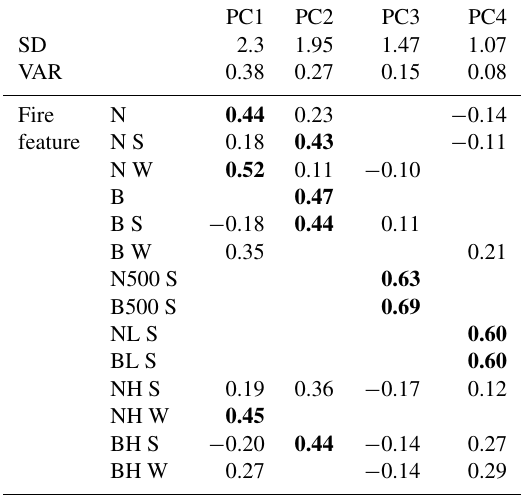
Table 4. Varimax rotation correlation values, standard deviation (SD) and variance (VAR) from principal component analysis on Sen’s slope results, 1974–2013. The most meaningful features (cor- relation > 0 . 43 or < − 0.43) are marked bold. See Sect. 2.1 for acronyms and description of fire features. PC1 PC2